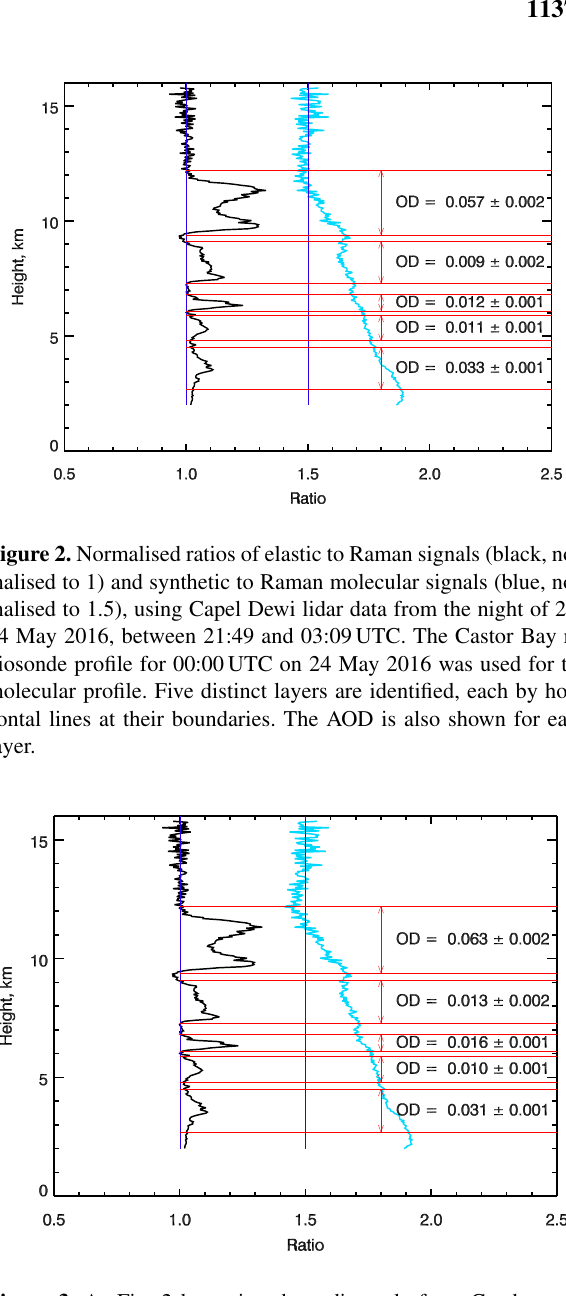
Figure 3. As Fig. 2 but using the radiosonde from Camborne at 00:00UTC on 24 May